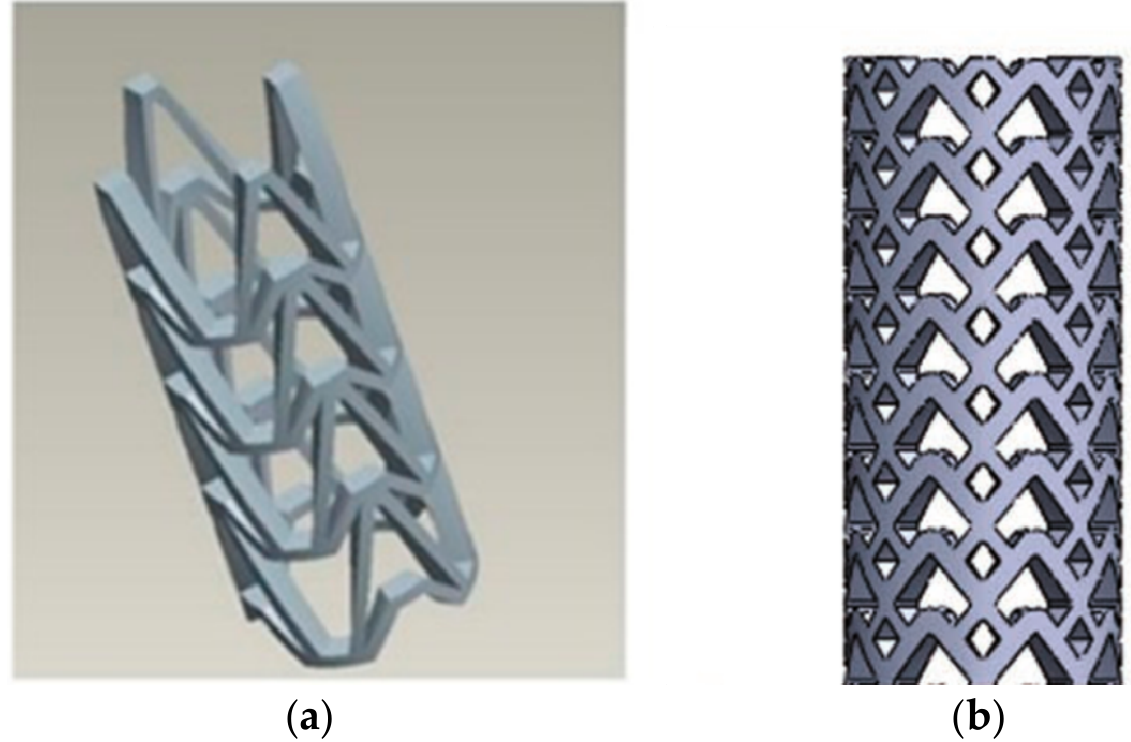
Figure 17. Arrowed stent: ( a ) Arrowed stent of Wu [119]; ( b ) Arrowed stent of Ameer [120–122].